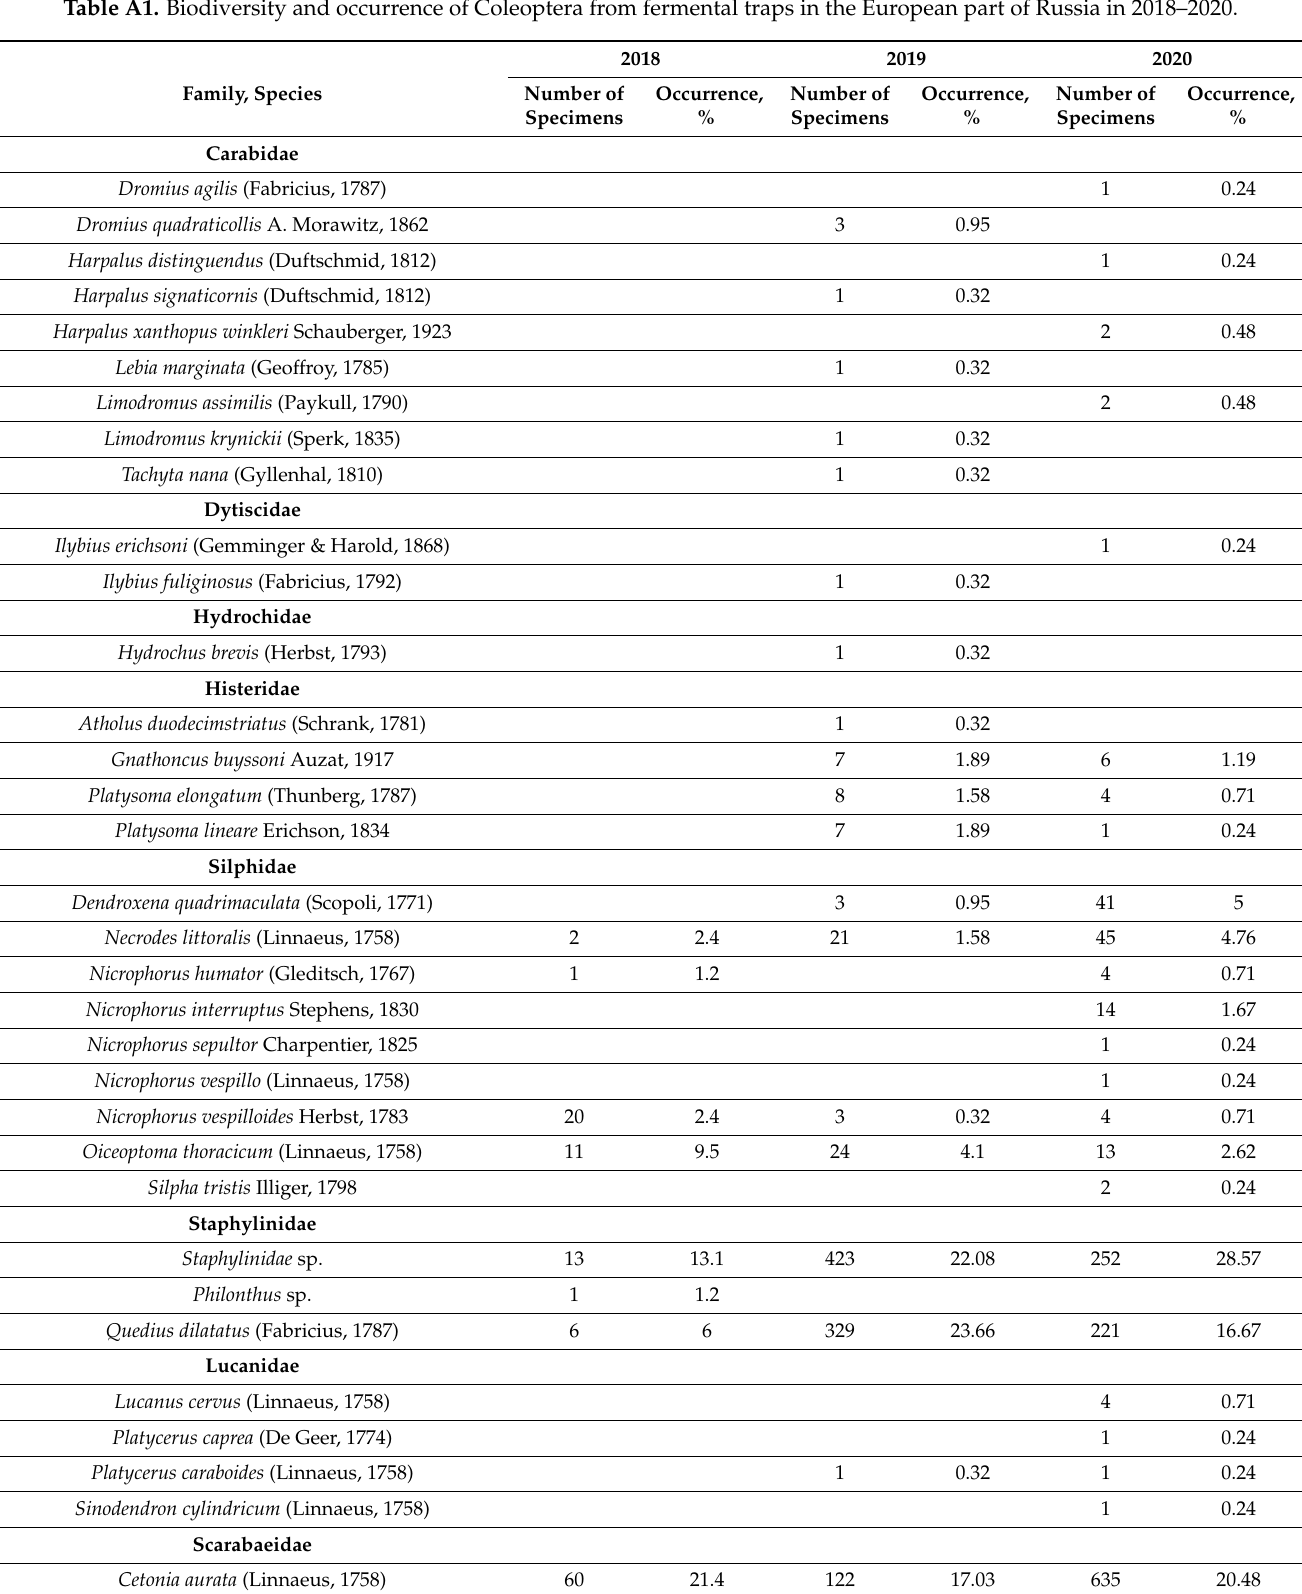
Table A1. Biodiversity and occurrence of Coleoptera from fermental traps in the European part of Russia in 2018–2020.